Question: Looking at the figure, what chart type is it?
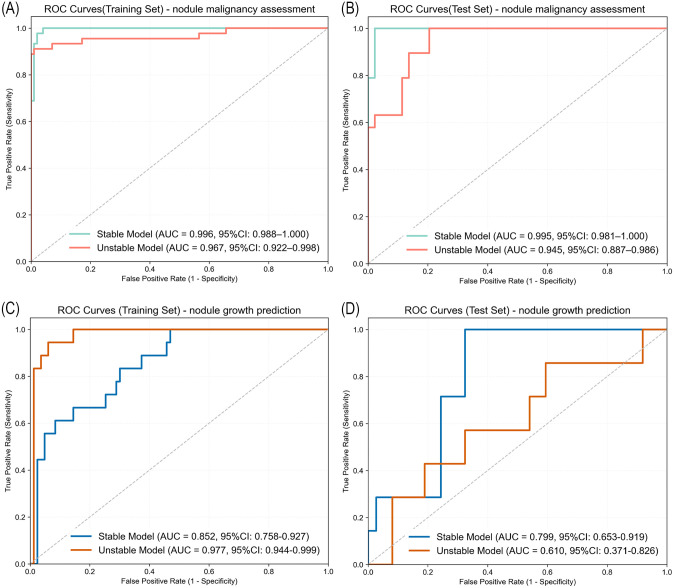
Answer: line